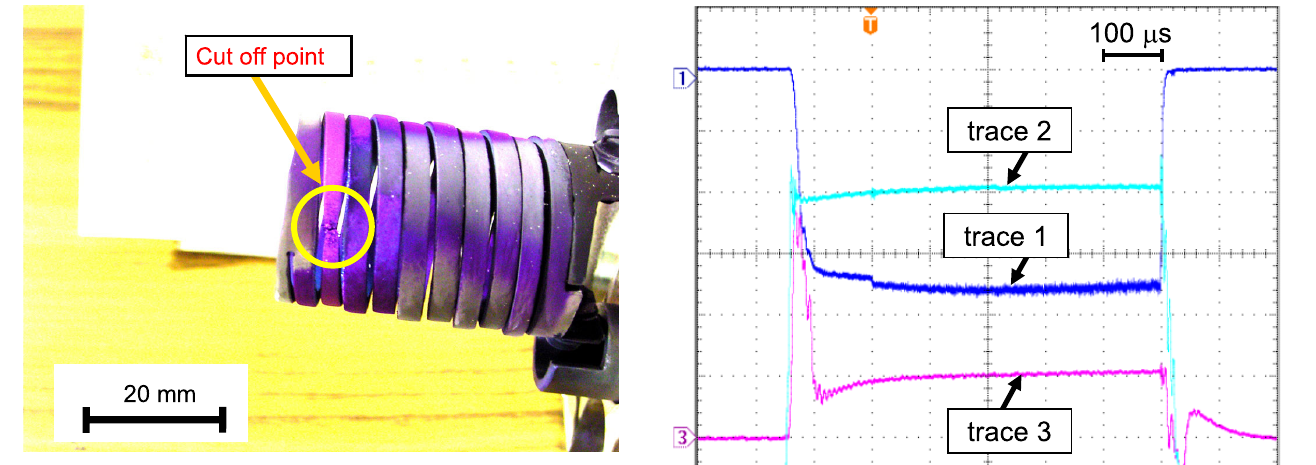
FIG. 13. (Color) Image of broken